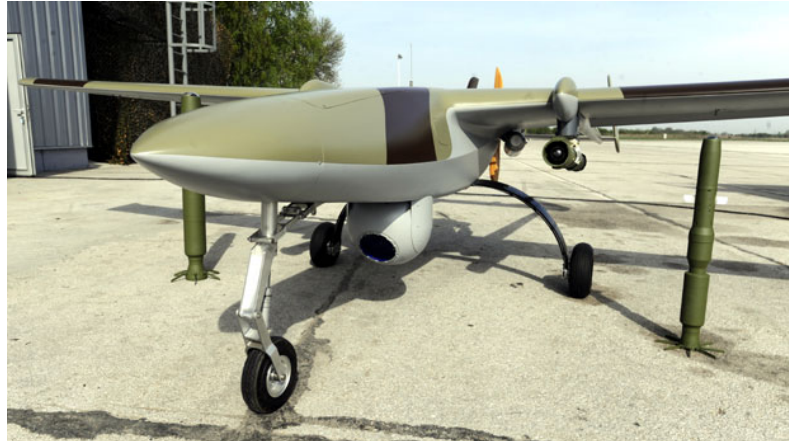
Figure 4 – Tactical unmanned aerial vehicle 'PEGAZ' (Dragovi ć , 2016) Рис . 4 – Тактический беспилотный летательный аппарат « ПЕГАС » Слика 4 ‒Тактичка беспилотна летелица великог долета „ ПЕГАЗ ” (Dragovi ć